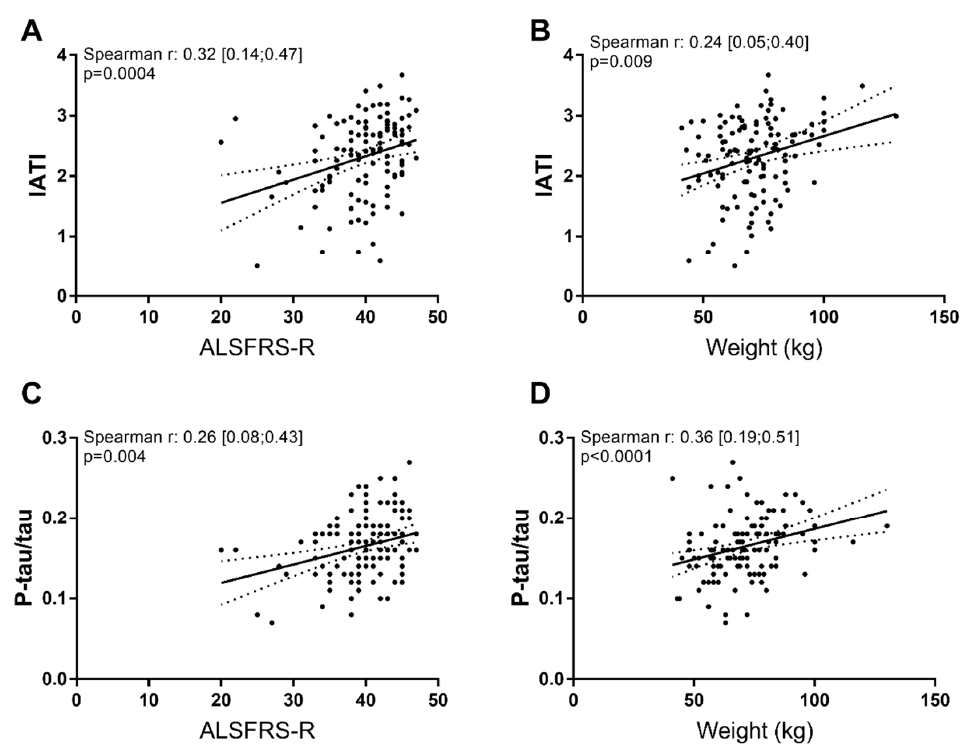
Figure 1. Significant correlations between biomarkers and clinical parameters at baseline. Innotest Amyloid Tau Index (IATI) ( A , B ) and ratio phosphorylated-Tau / total Tau (P-tau / tau) ( C , D ) correlated with ALSFRS-R and weight at baseline.